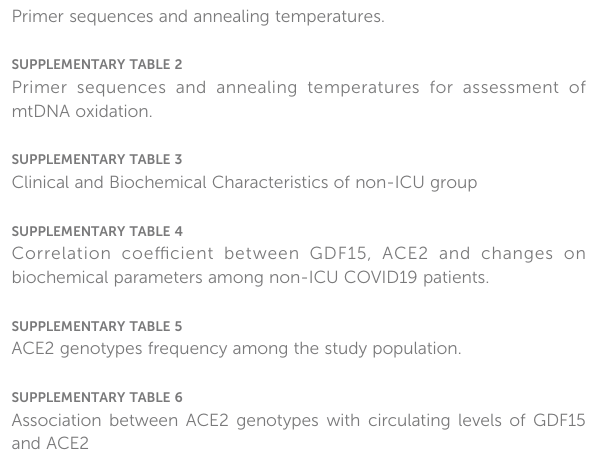
SUPPLEMENTARY FIGURE 4 GDF15 and ACE2 levels across ACE2